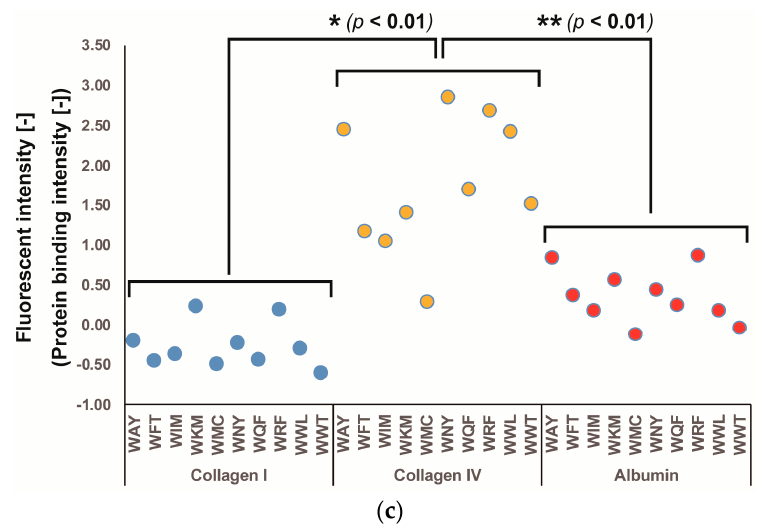
Figure 3. Results of screening for ECM-selective peptides. ( a ) The average fluorescence intensities of triplicate peptide spots are summarized for all clusters with box plots. The label “All” refers to the summarized value of all 500 tripeptides. For each cluster, the median value of the ten peptides is shown as a horizontal line, the 50% quantile area is shown as a box, and the standard deviation is shown as whiskers; ( b ) Correlation between Col IV and Col I or Alb in 50 clusters. Numeric character indicates cluster number. Red dots: cluster 21, blue dots: cluster 12; ( c ) Detailed plot of peptide binding rates in cluster 21 (Col IV-selective adhesion cluster). Each plot is representative of nine data points (triplicate spots from three different arrays). Fluorescence intensity values were normalized by standard normalization (average = 0, standard deviations = 1). * Denotes statistical significance compared to collagen I, p < 0.01, Student’s t -test. ** Denotes statistical significance compared to albumin, p < 0.01, Student’s t -test.